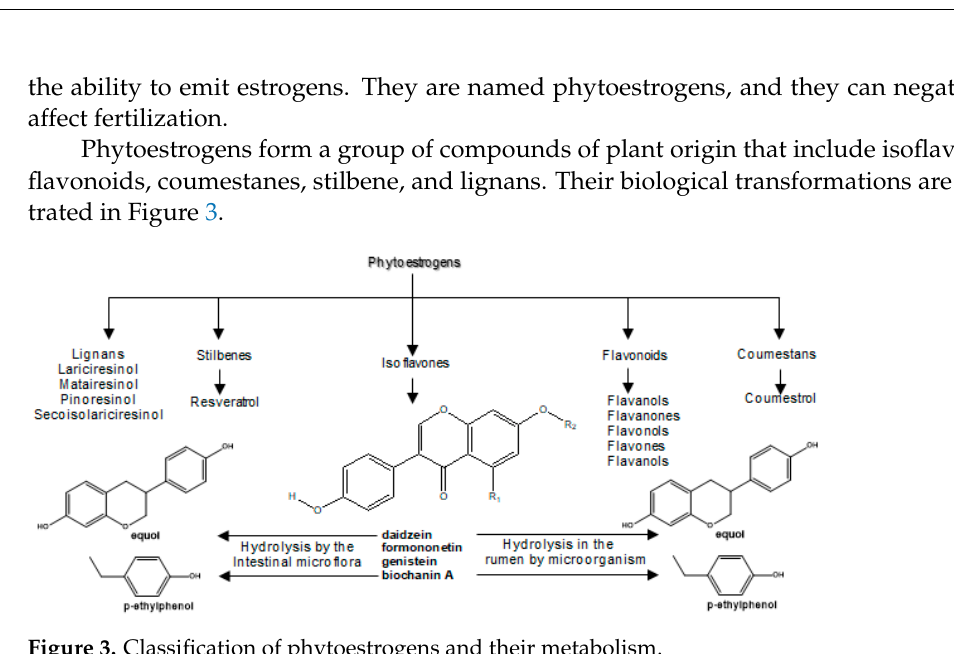
Figure 3. Classification of phytoestrogens and their metabolism.